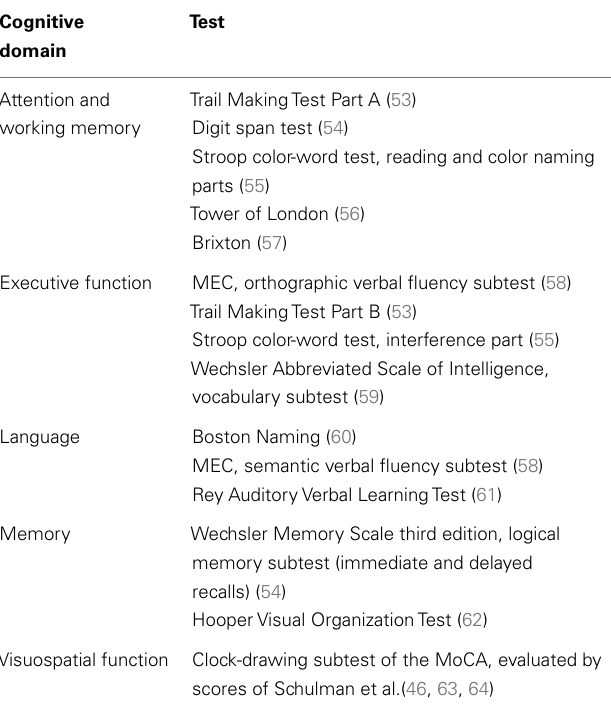
Table 2 | Neuropsychological test battery according to cognitive domain